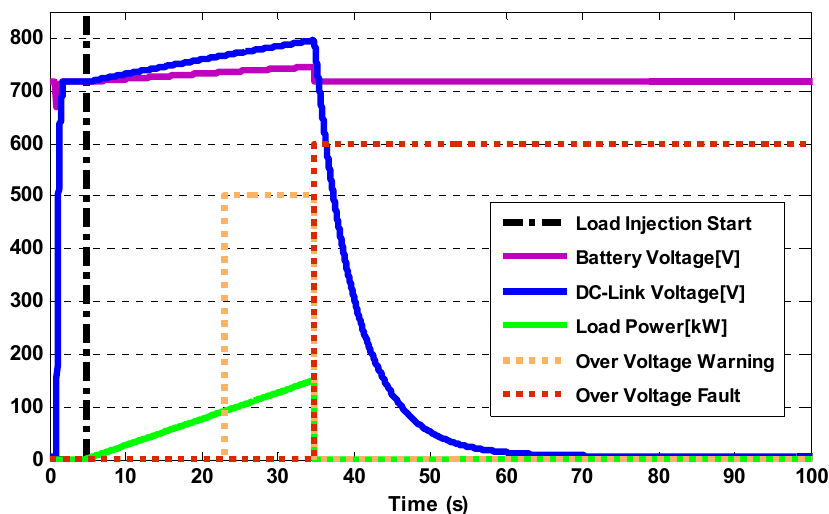
Figure 14. Fault simulation